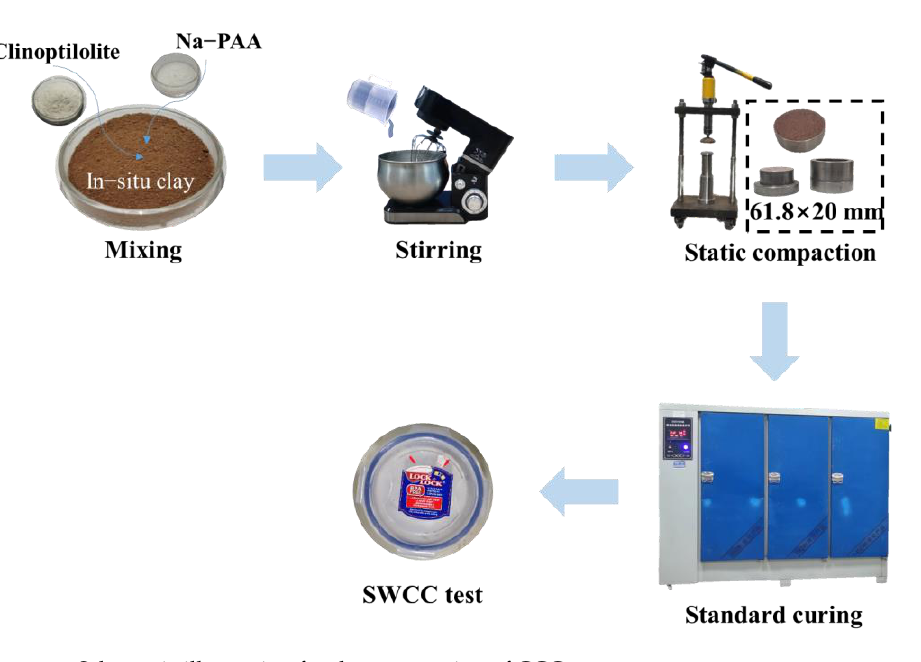
Figure 7. Schematic illustration for the preparation of CCC. Table 3. Details of the experimental program. Replacement Content of Group No. Clinoptilolite